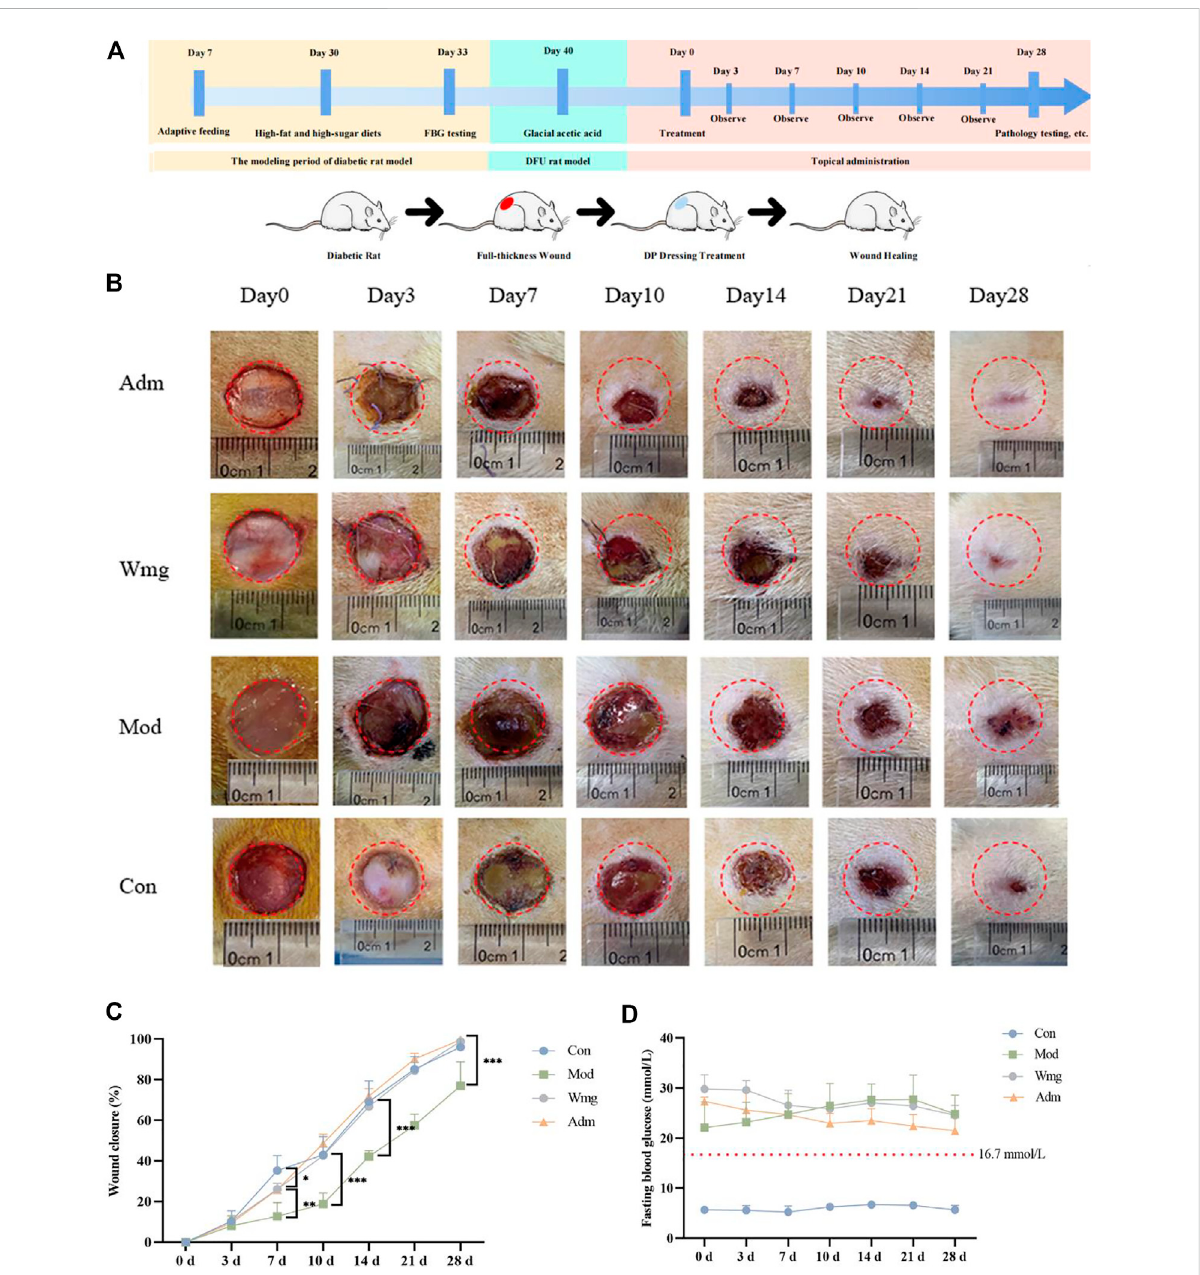
FIGURE 3 DP improves thewoundsof DFU rats. (A) The time diagram of theexperiment. (B) Representative fi gures ofdifferenttime points ofhealing area of DFU rats. (C) Wound closure (%) of different groups at days 0, 3, 7, 14, 21 and 28. * p < 0.05 represent signi fi cance. (D) Images present the levels